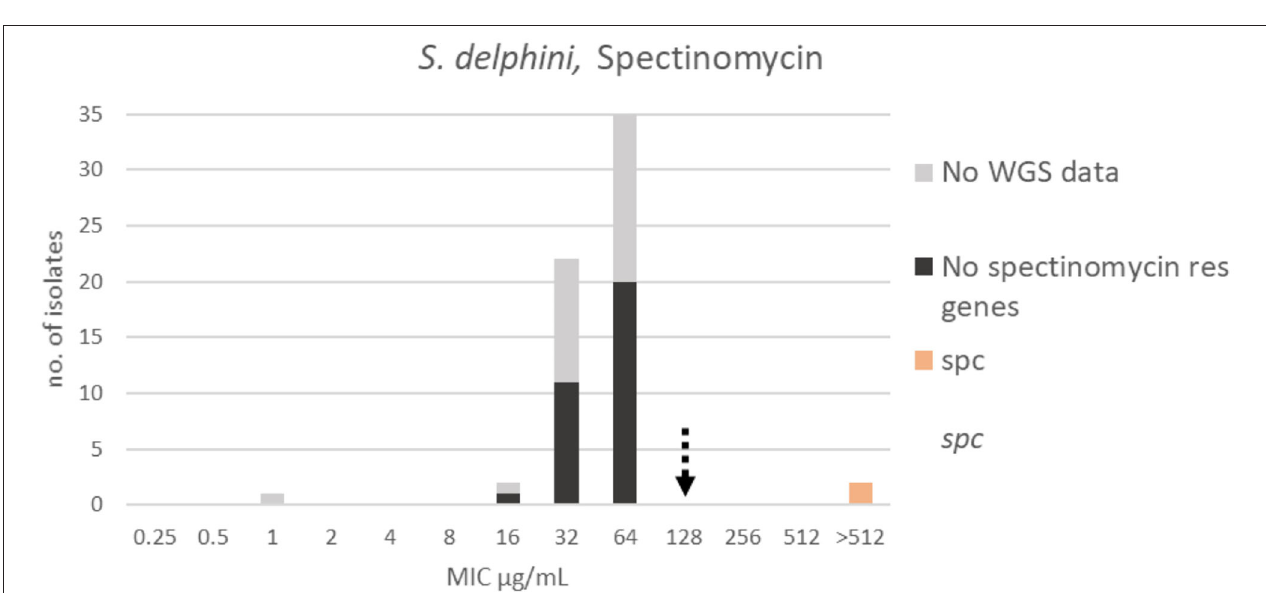
FIGURE 9 | MIC distribution Staphylococcus delphini ( n = 63) against spectinomycin in the test range 0.25–512 µ g/mL. The broken arrow indicates the tentative epidemiological cut-off value (TECOFF). Colors indicate if the isolates have been sequenced and whether they habor known relevant resistance genes. WGS, whole-genome sequencing; res, resistance.